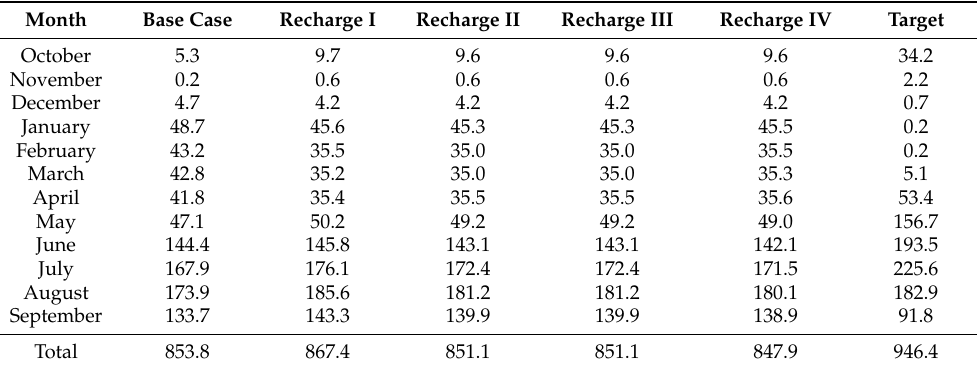
Table 7. A monthly average delivery to the agricultural region near the groundwater basin at CVPM8 and its target delivery in hm 3 .